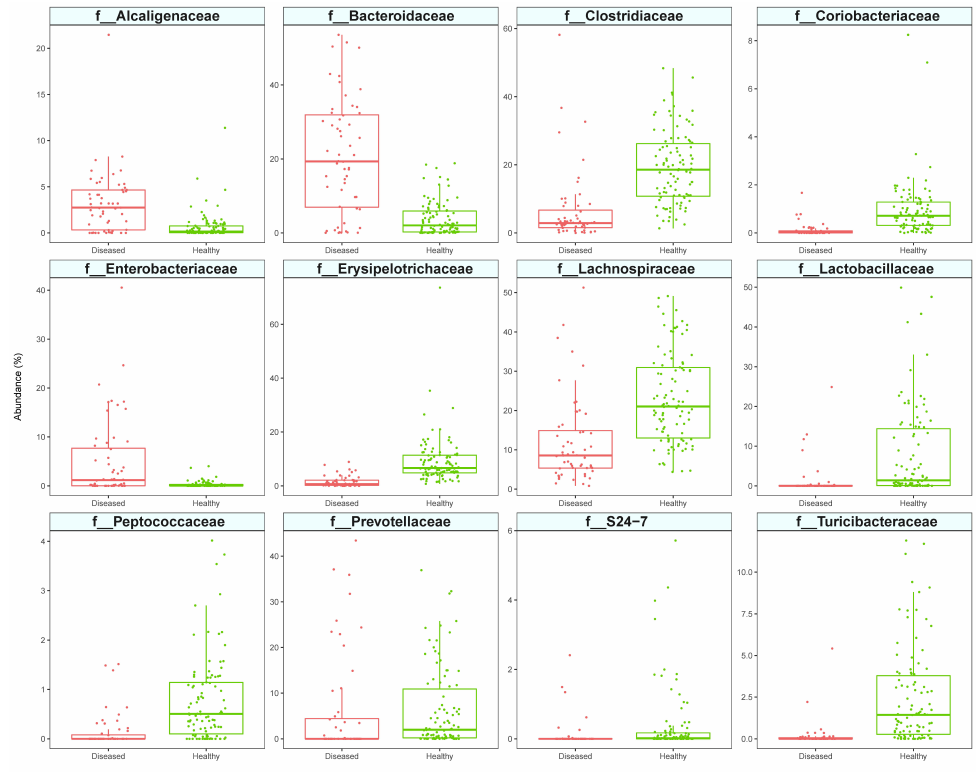
Figure 3. Differentially abundant families between healthy (green) and chronic enteropathies (CE) affected (red) dogs.